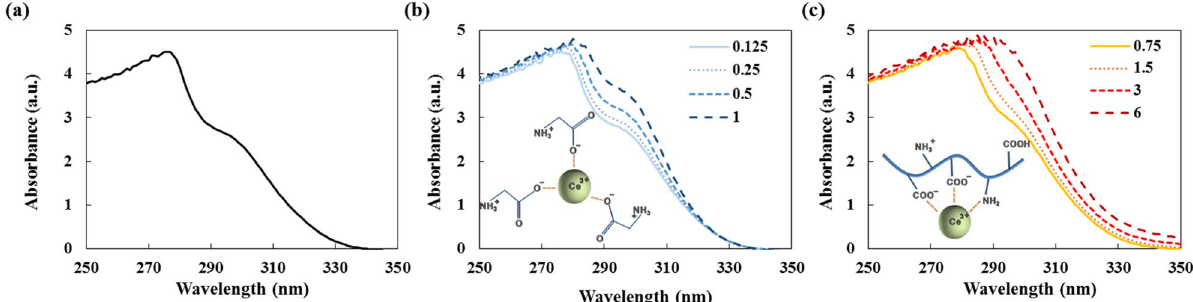
Figure 3. UV–Vis absorbance spectra of 0.05 M GDC precursor solution in ( a ) 60/40 aqueous ethanol, ( b ) glycine solution, and ( c ) gelatin solution. The legend indicates the wt% concentration of each organic molecule. The inset images describe the interacting elements in each solution.